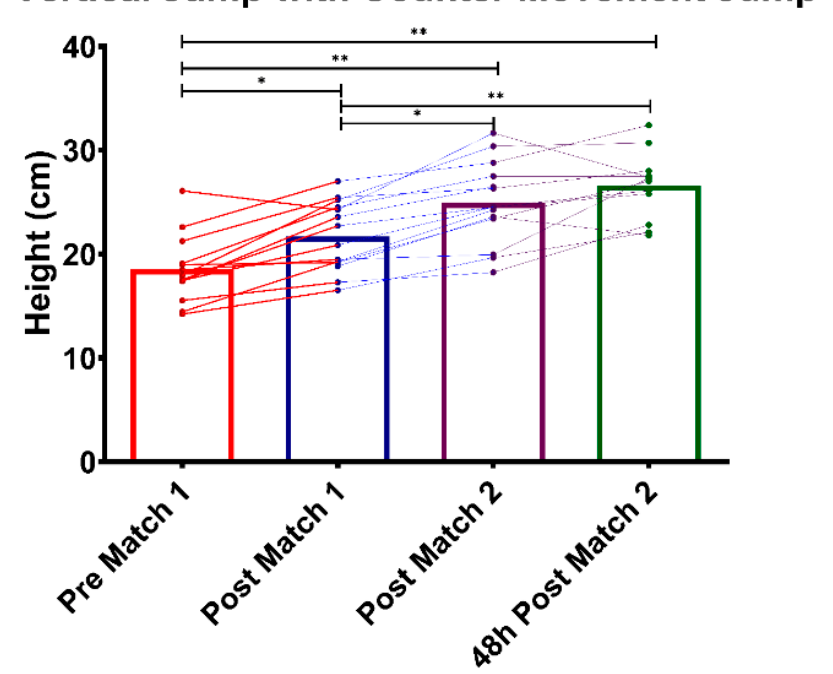
Figure 4. Mean and individual variations in the countermovement jump height at the different tests. * represents a significant difference at p < 0.05, and ** represents a significant difference at p < 0.001.